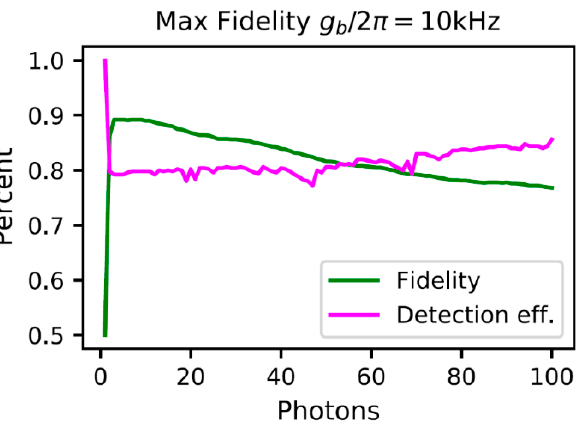
Figure 7. The maximum achievable fidelity and corresponding efficiency vs. number of incident photons.